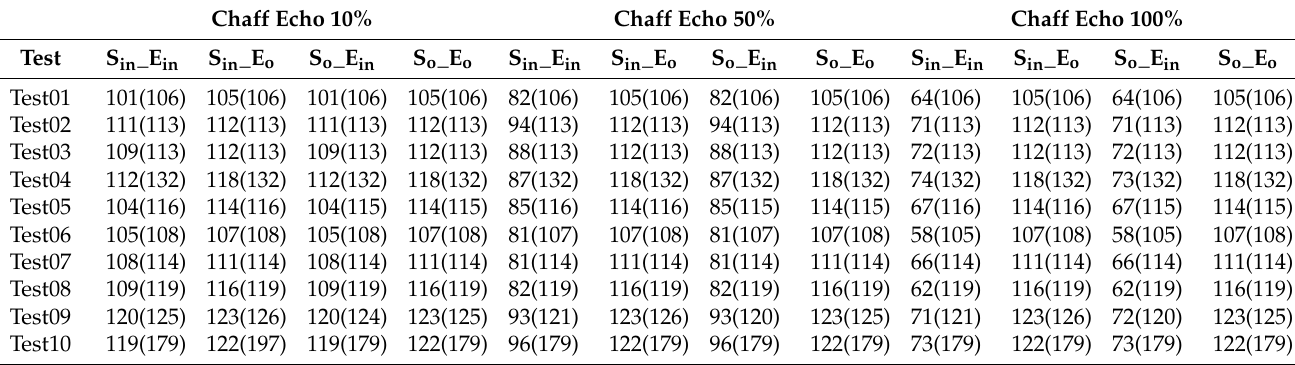
Table 4. Packet cross-matching results with Echo chaffed rate 10%, 50%, and 100% at AWS1. Chaff Echo 10% Chaff Echo 50% Chaff Echo